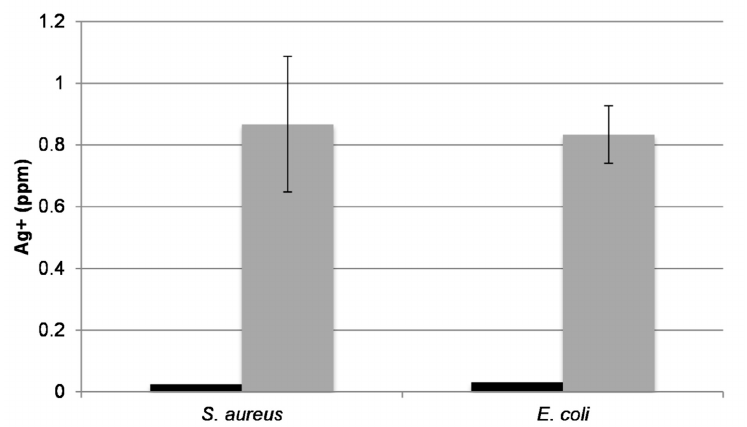
Figure 6. ICP-MS analysis of Ag + from growth curve samples shown in Figure 5. Samples were removed at the end of the 6-h time course. Black bars represent samples taken from cultures treated with the uncoated Ti discs while the gray bars represent samples treated with Ag x O-coated Ti discs. Error bars represent ranges for Ag x O samples based on the replicate from each bacterial strain.